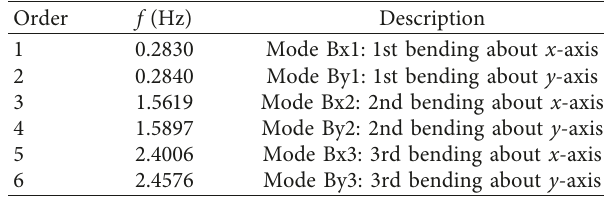
Figure 2: FE model of the wind turbine tower with caisson foundation. (a) FE model. (b) Sensor location. Table 3: Natural frequencies of free vibration